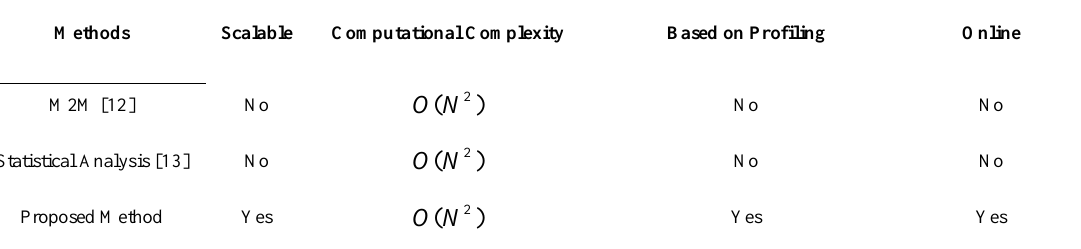
Table 1. Summary of results on performance and quality of methods; the first two rows are the consequences of machine to machine method [12], and statistical analysis and anomaly detection on SMS social network [13]. The new profiling method in the paper provide an online, scalable and efficient approach in row 3.s